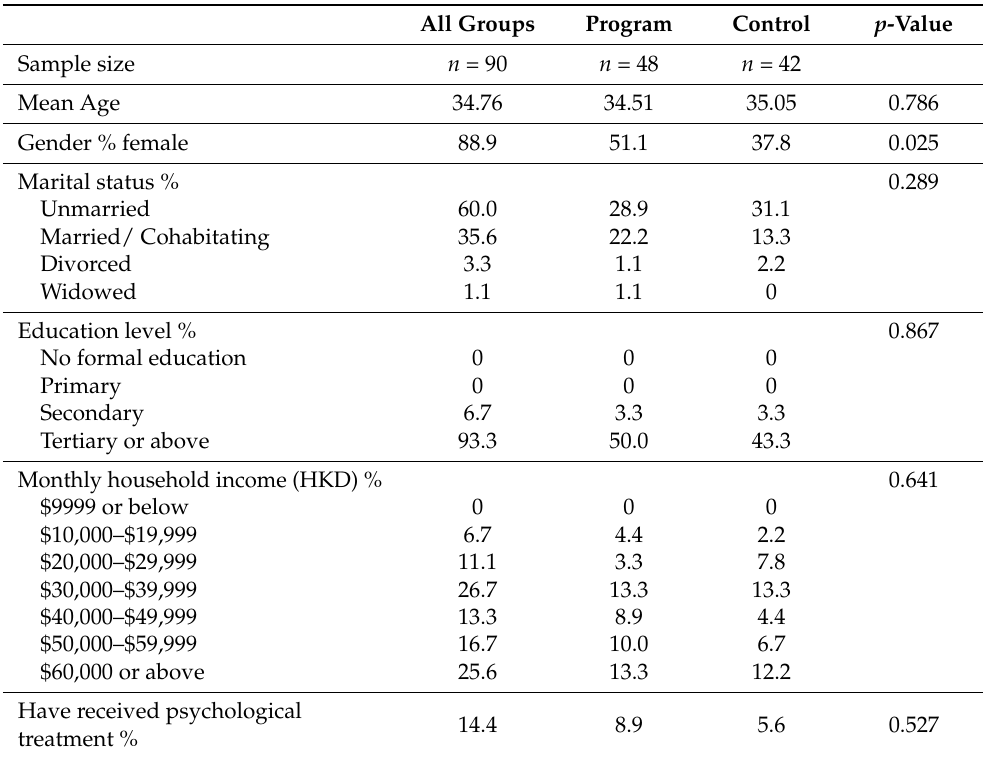
Table 1. Background characteristics of the participants at baseline.